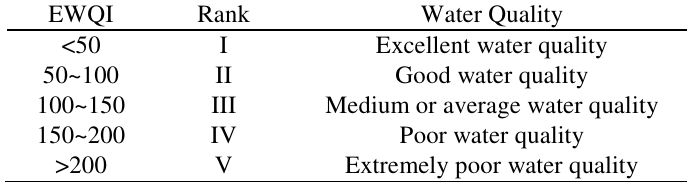
Table 1. Classification standards of groundwater quality according to